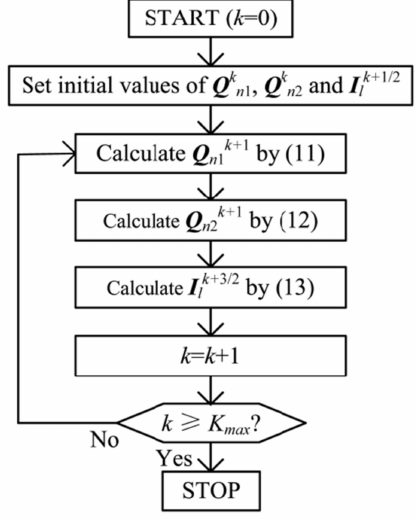
Figure 2. Layout of the whole